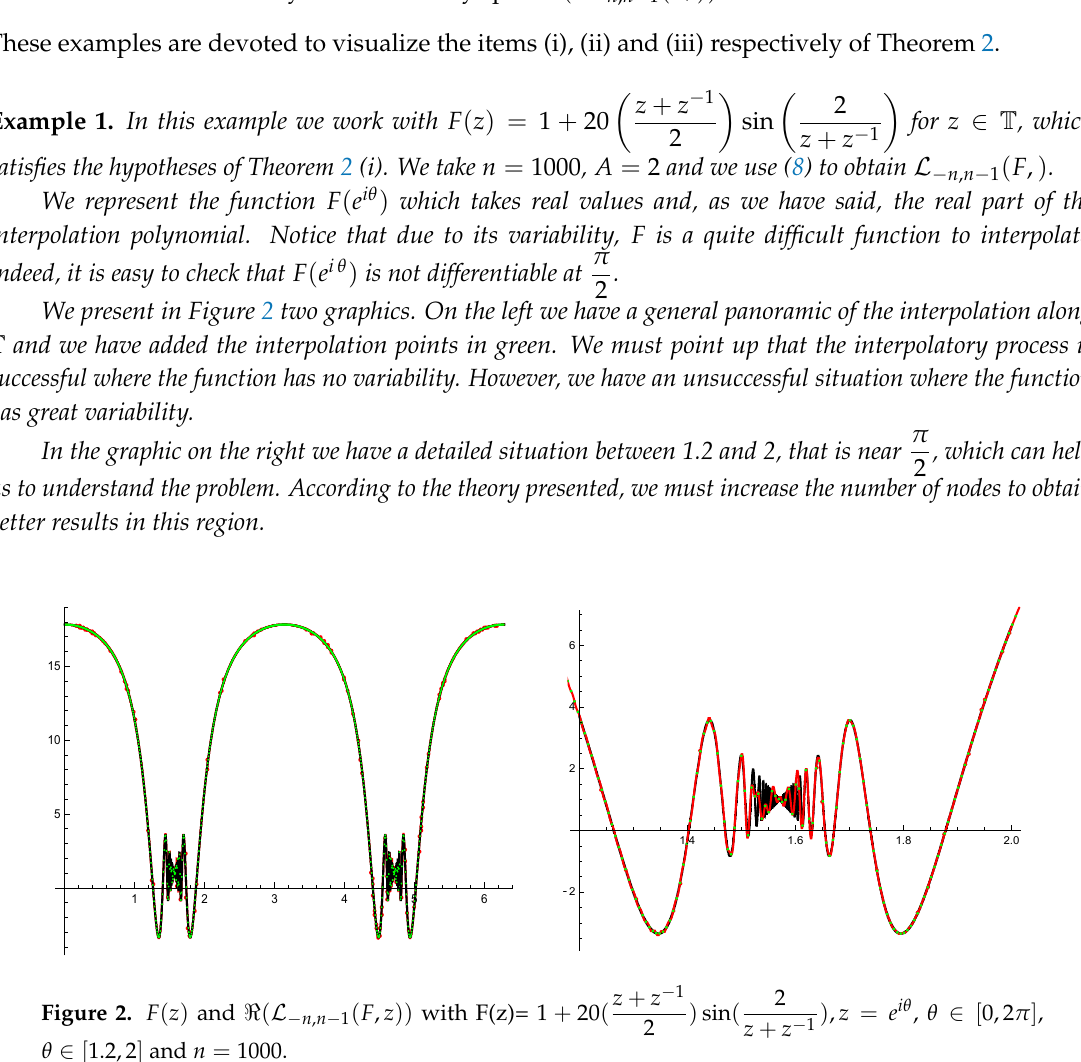
Figure 2. F ( z ) and (cid:60) ( L − n , n − 1 ( F , z )) with F(z)= 1 + 20 ( θ ∈ [ 1.2,2 ] and n =